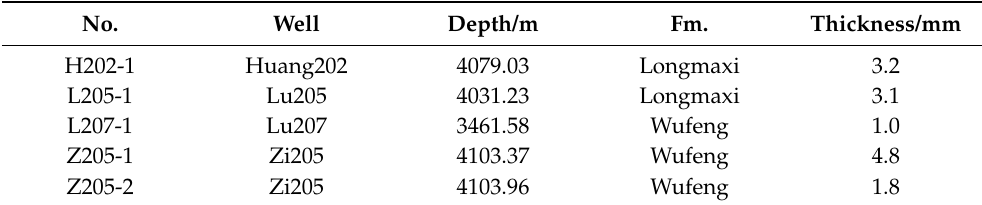
Table 1. Information about radiolarian-rich shale laminae.